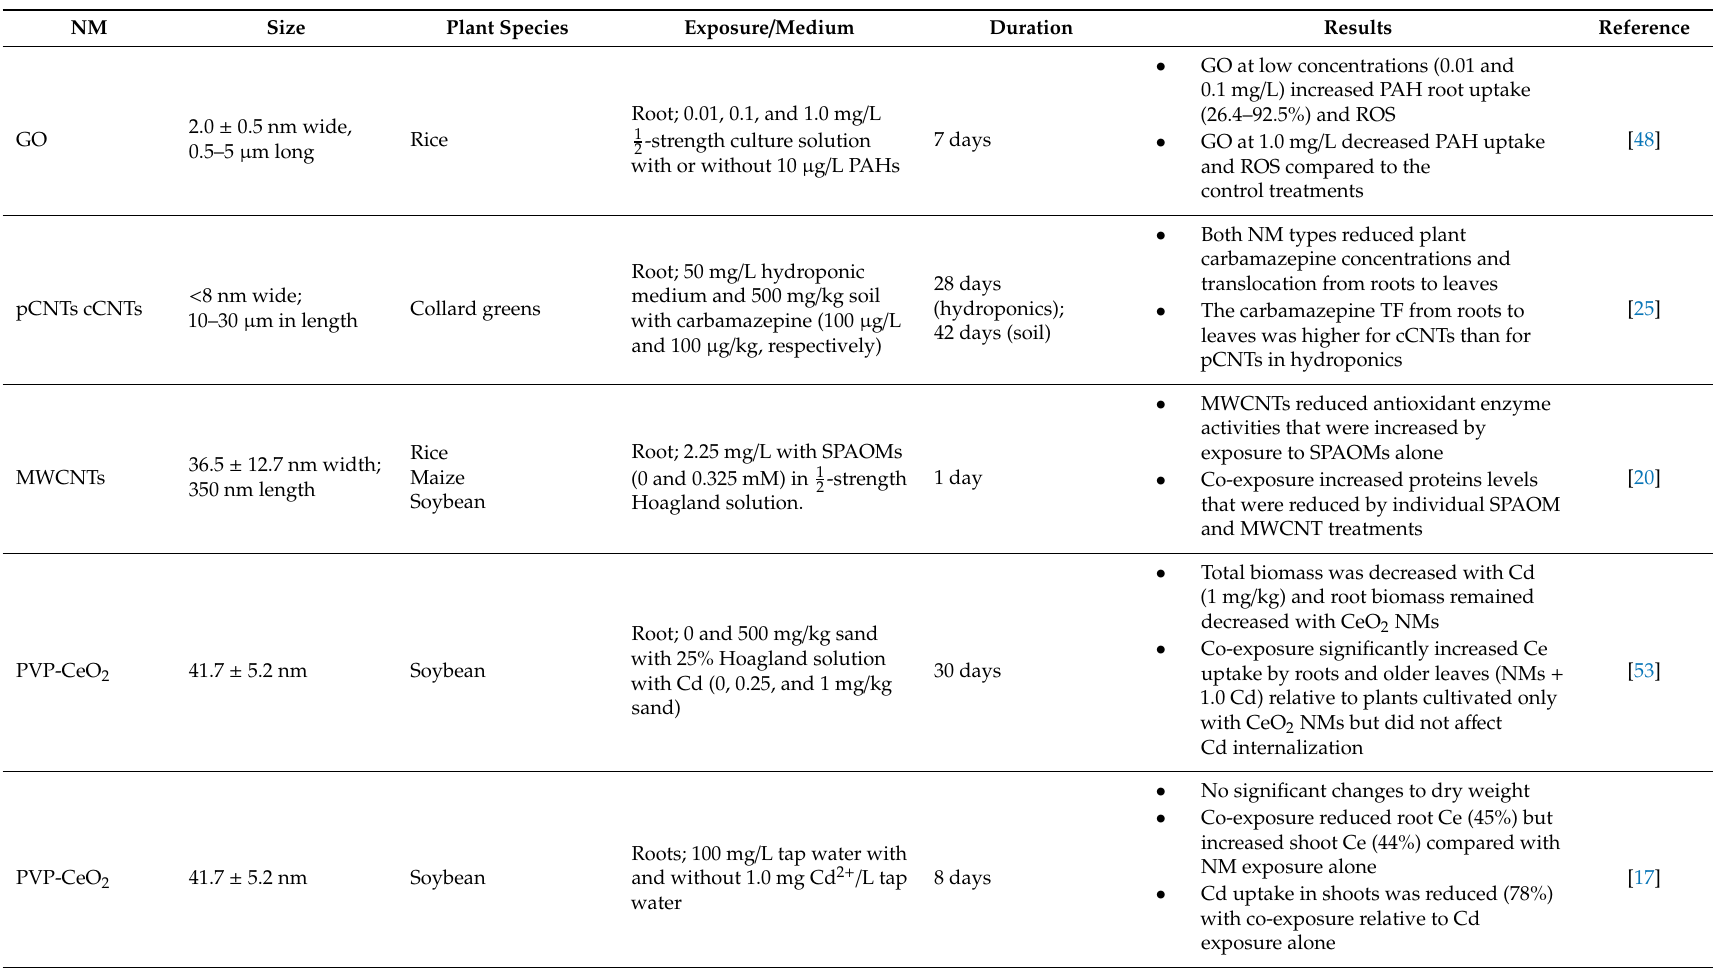
Table 2. Summaries of recent ENM co-exposure studies from 2017 and